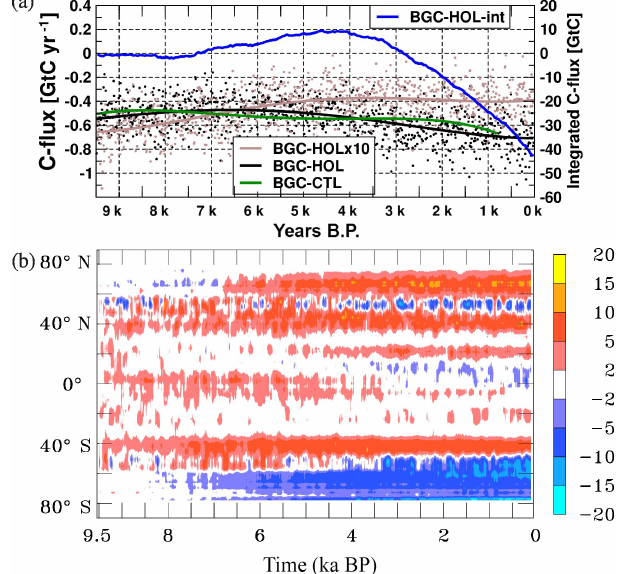
Figure 6. As Fig. 2 but (a) for the global atmosphere–ocean car- bon flux (GtCyr − 1 ) of experiments BGC-HOL (black), BGC- HOLx10 (brown), and BGC-CTL (green), and the integrated atmosphere–ocean carbon flux for BGC-HOL (GtC, blue). Negative values indicate oceanic outgassing. The net outgassing of around 0.5GtCyr − 1 balances the river input of carbon. (b) Hovmöller di- agram of the zonal mean atmosphere–ocean carbon flux change (mol Cm − 2 s − 1 ) of experiment